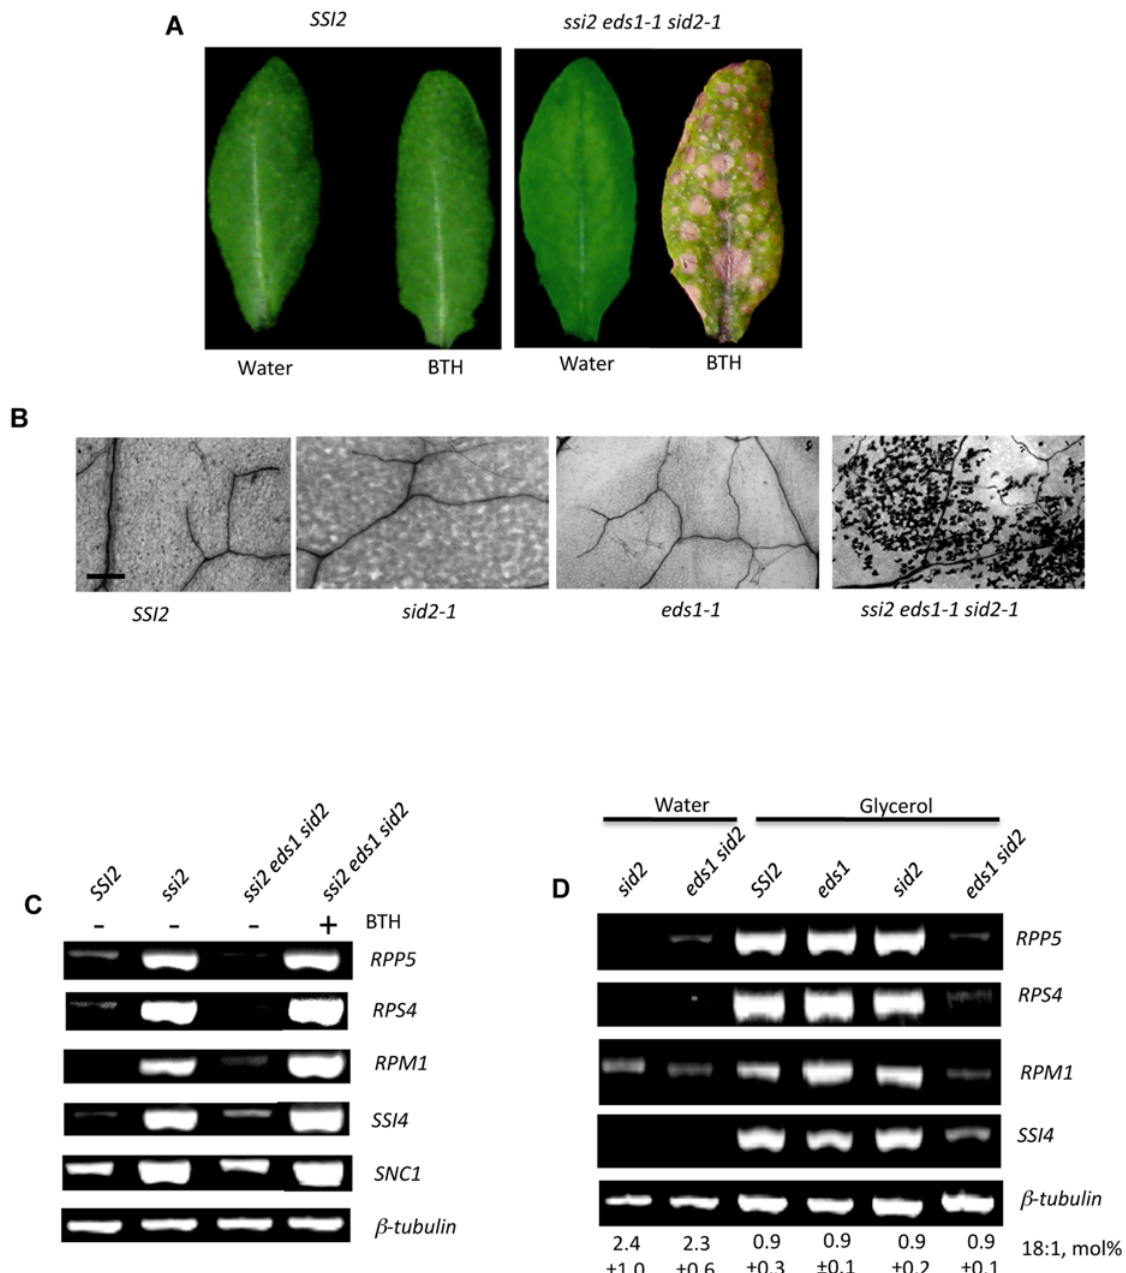
Figure 2. Restoration of ssi2 phenotypes in ssi2eds1-1sid2-1 plants and glycerol responsiveness of eds1-1sid2-1 plants. (A) Visual phenotypes of water- or BTH–treated wt ( SSI2 ; Col-0 ecotype) and ssi2 eds1-1 sid2-1 plants. The plants were photographed at 2 days post treatment (dpt). (B) Microscopy of trypan blue-stained leaves from BTH–treated wt ( SSI2 ; Col-0 ecotype), sid2 , eds1-1 and ssi2 eds1-1 sid2-1 plants. The plants were treated with BTH and stained at 2 dpt (scale bars, 270 microns). (C) RT–PCR analysis of R genes in water- or BTH-treated ssi2 eds1-1 sid2-1 plants. Untreated wt ( SSI2 ; Col-0 ecotype) and ssi2 plants were used as controls. The expression of R genes in EDS1 SID2 F2 plants was similar to that of wt plants (data not shown). The level of b -tubulin was used as an internal control to normalize the amount of cDNA template. (D) RT–PCR analysis of various R genes in water- or glycerol-treated sid2-1 and eds1-1 sid2-1 plants. The glycerol-treated wt ( SSI2 ; Col-0 ecotype) and eds1-1 were included as additional controls. The expression of R genes in water- or glycerol-treated EDS1 SID2 F2 plants was similar to that of water- or glycerol-treated wt plants, respectively (data not shown). The expression of R genes in wt and eds1-1 plants was similar to that seen in sid2-1 or eds1-1 sid2-1 plants. The plants were treated with water or glycerol for three days and analyzed for 18:1 levels and R gene expression. The level of b -tubulin was used as an internal control to normalize the amount of cDNA template. The 18:1 content of each genotype is shown as mol% 6 SD.